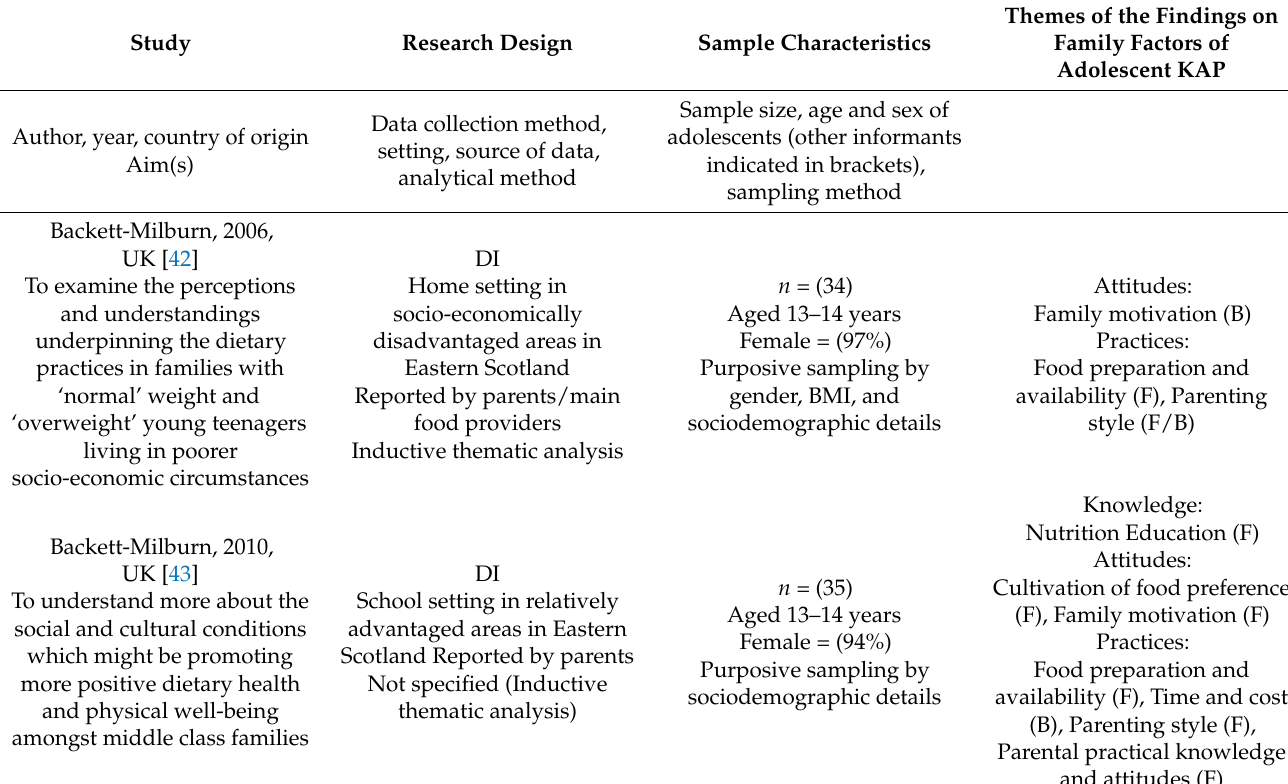
Table 2. Summary table of reviewed